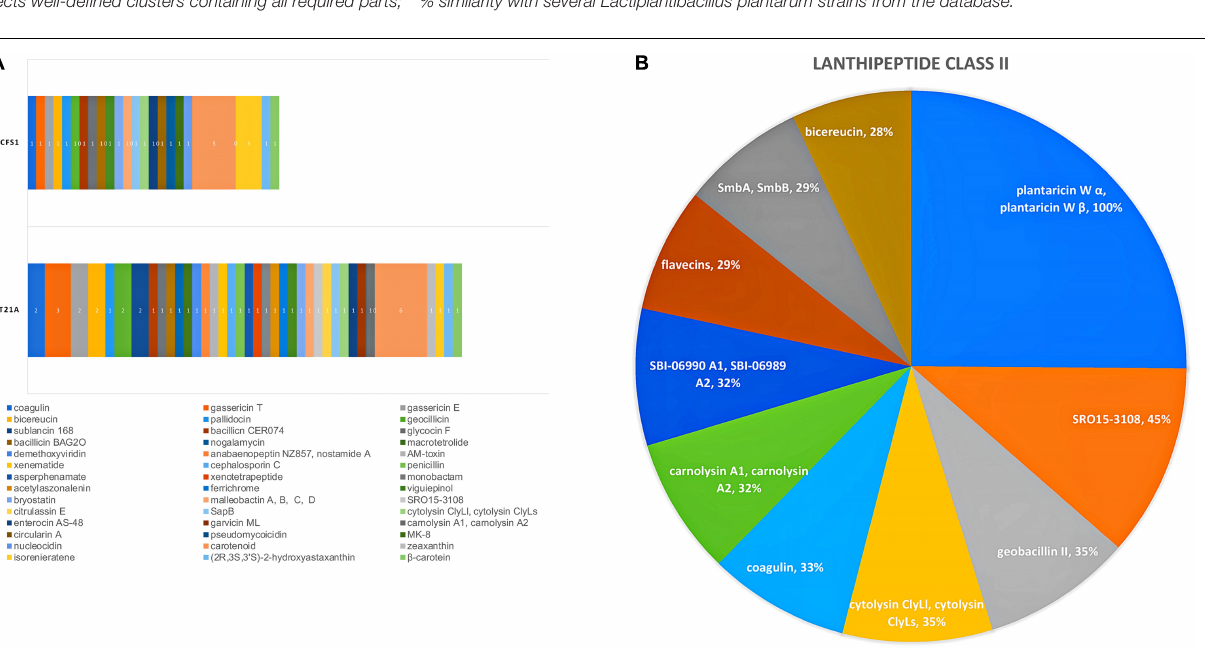
FIGURE 5 | (A) Comparison between the secondary metabolite clusters detected in the UTNGt21A genome and the reference L. plantarum WCFS1 strain. Different colors and numbers marked the compounds produced by each strain. (B) Pie chart depicting different compounds of lanthipeptide Class II predicted for UTNGt21A. The current region sequence similarity (%) with the reference MIBiG database is